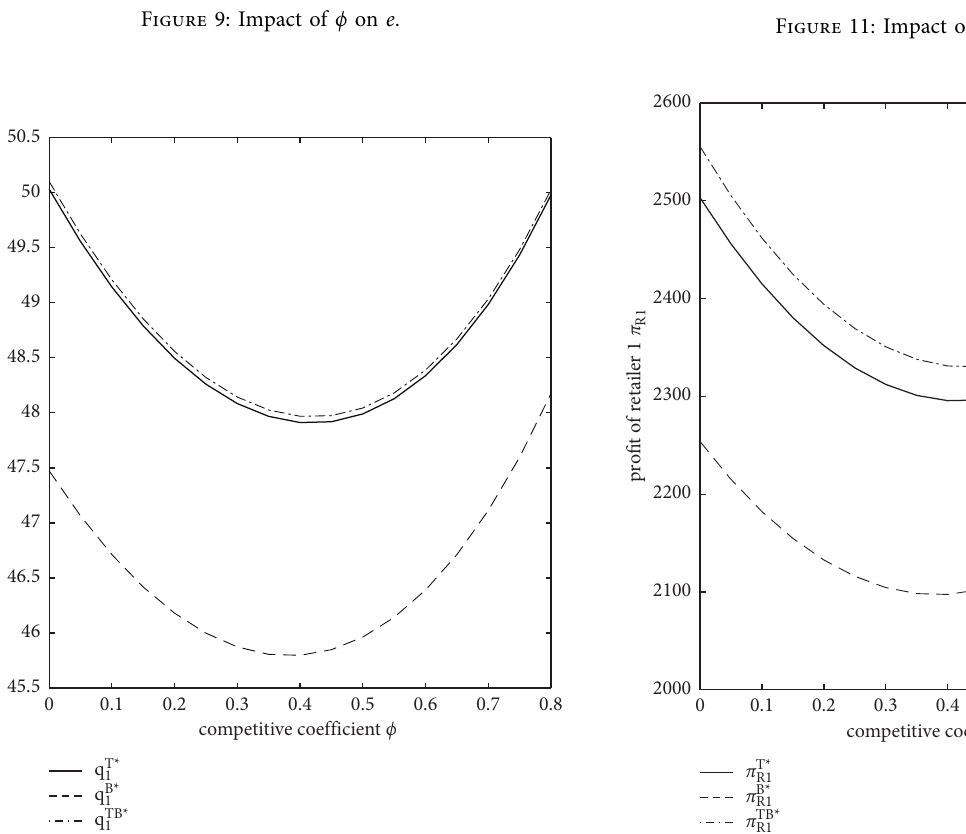
Figure 10: Impact of ϕ on q